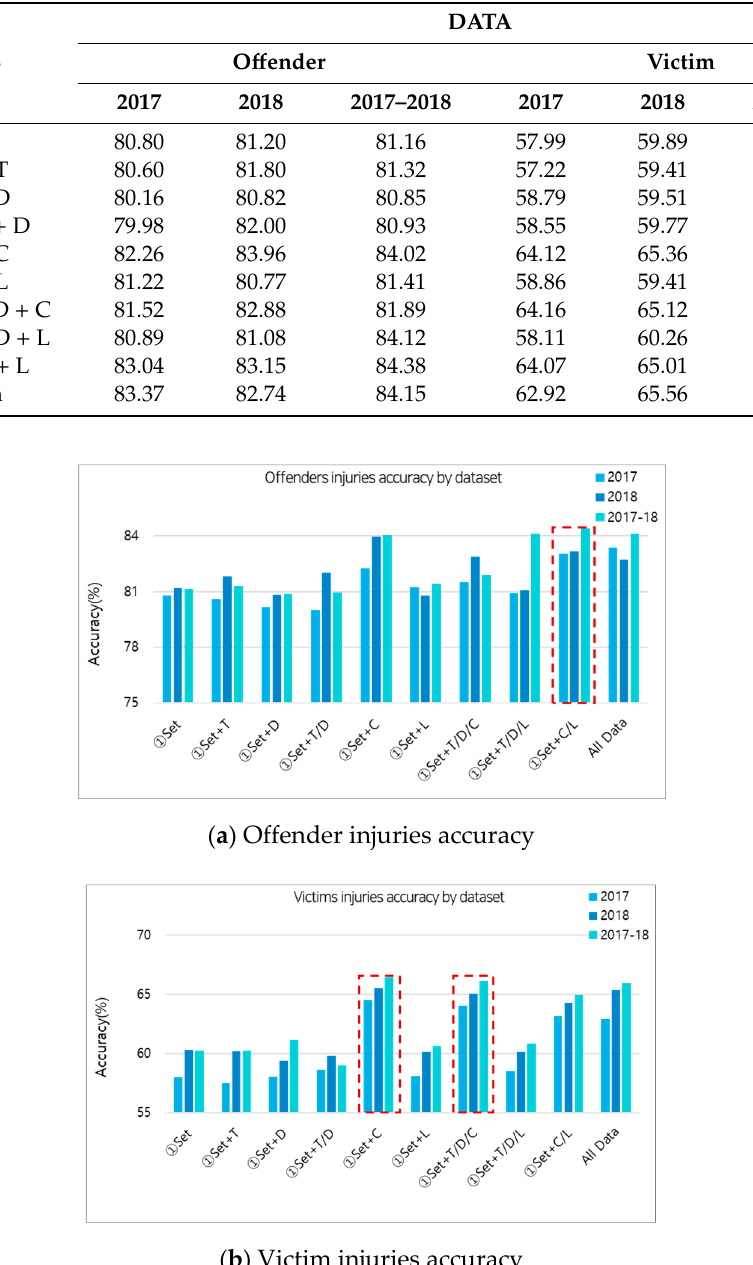
Table 4. O ff ender / Victim Injuries Accuracy by datasets.